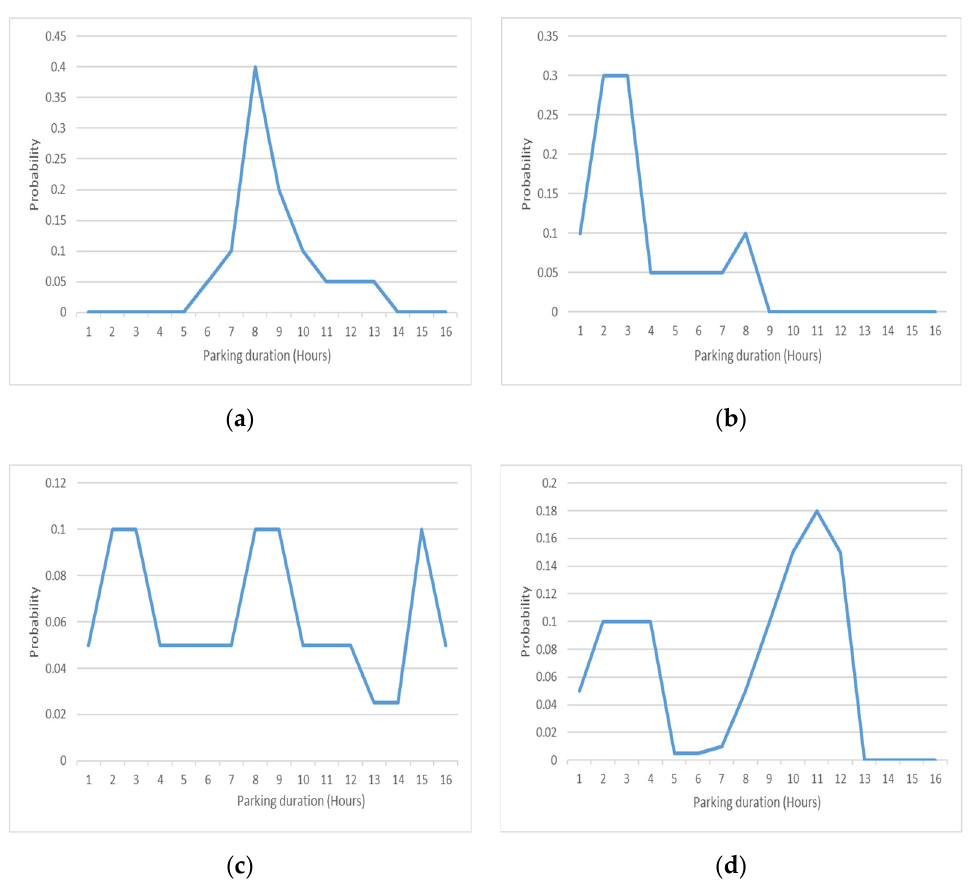
Figure 2. PEV parking duration probability when they arrive between ( a ) 00:00 to 8:00, ( b ) 9:00